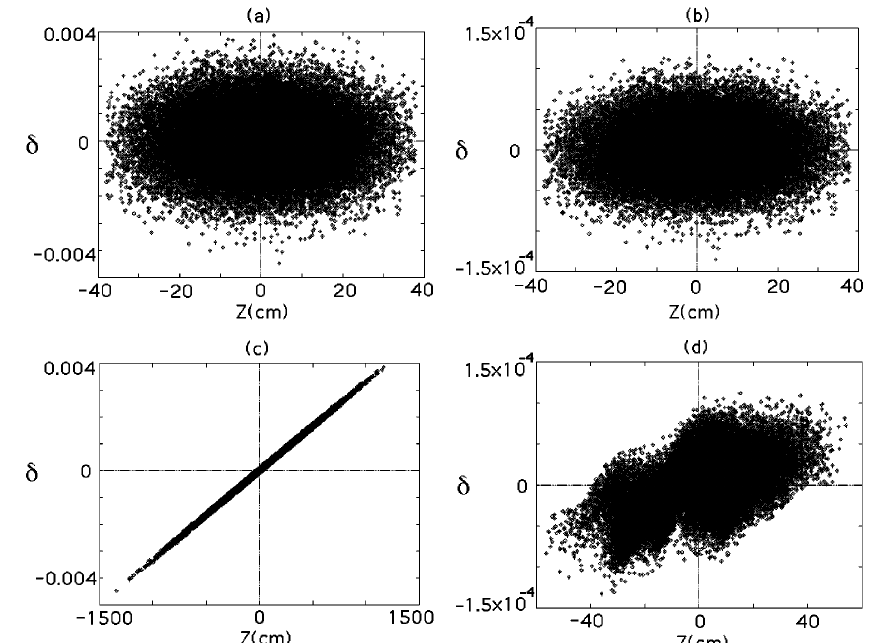
FIG. 8. The longitudinal phase space after 1000 turns for different values of s d and h (cid:49) , with, in contrast to Figs. 7(a)–7(d), two rf cavities used to compensate the bunch wake. The rf corresponds to Table II, column 3. The situation is improved when two rf cavities are used, as shown in (a), (b), and (d). The values of s d and h (cid:49) in (a)–(d) correspond to their respective values in Figs. 7(a)–7(d). The motion in Figs. 7(c) and 8(c) is dominated by slippage, and the rf does not affect the dynamics. In each j (cid:173) (cid:48)(cid:46)(cid:49) V . figure, j (cid:90) jj (cid:110) (cid:104)